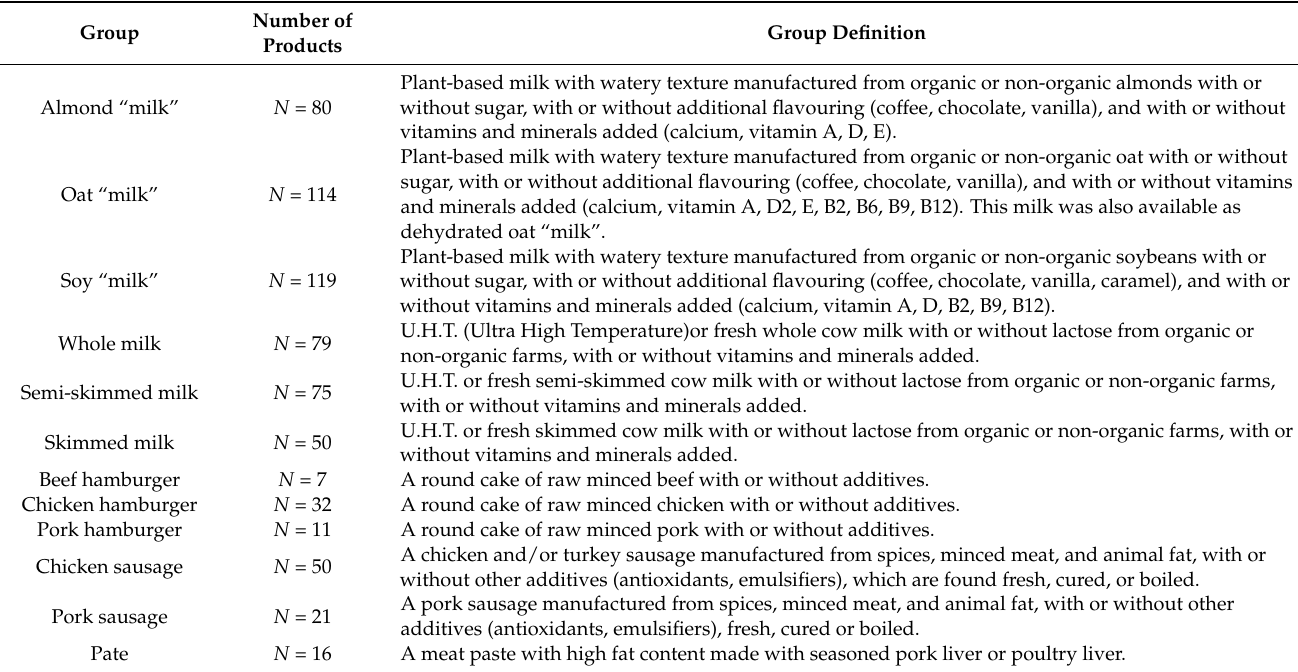
Intakes; Table S4: Coverage of daily intake (%) for nutrients by energy and selected nutrients in adults per 100 mL of PB “dairy product alternatives” and AB dairy products according to Reference Intakes; Table S5: Nutrient profiling models according to Nutri-Score, NOVA, and ECO-Score for AB milks and foods; Table S6: Nutritional information from the pack labelling, per 100 g of PB products reported in other studies; Figure S1. Boxplots of the nutrient composition, per 100 mL of PB oat “milk” and AB milks; Figure S2. Boxplots of the nutrient composition, per 100 mL of PB almond “milk” and AB milks; Figure S3. Boxplots of the nutrient composition, per 100 mL of PB soy “milk” and AB milks; Figure S4: Boxplots of the nutrient composition profiles, per 100 g of PB and AB